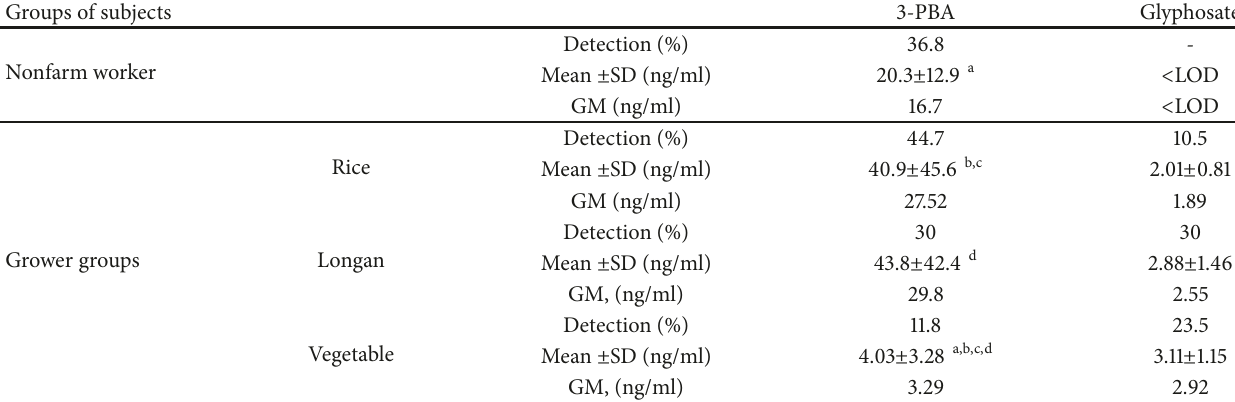
Table 5: Urinary biomarkers of synthetic pyrethroid (3-phenoxybenzoic acid: 3-PBA) and glyphosate exposure, by study group. Groups of subjects